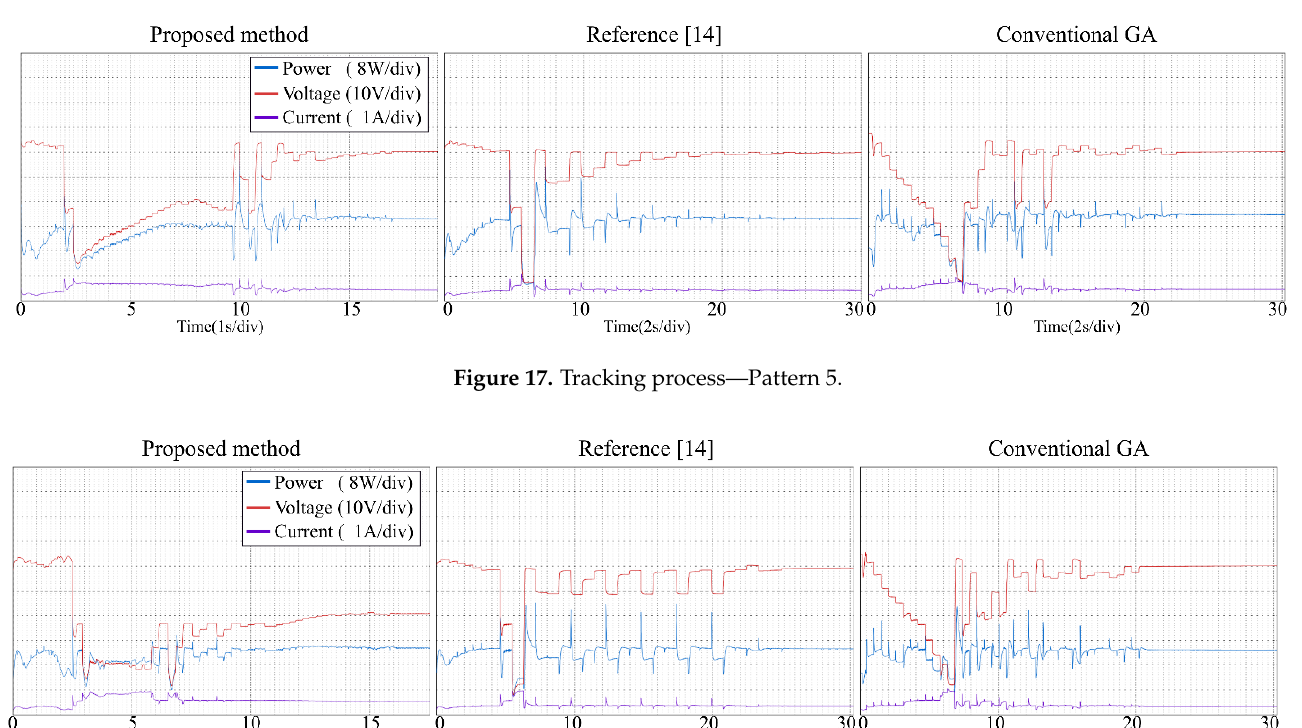
Figure 16. Tracking process—Pattern 4.